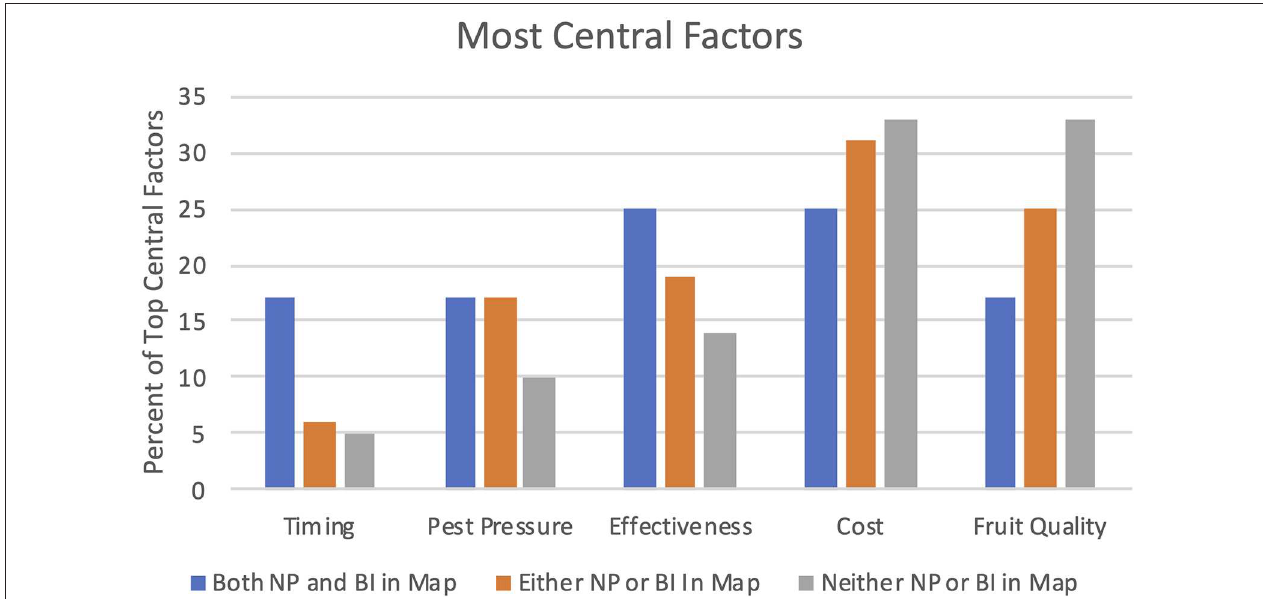
FIGURE 4 | The five highest-scoring factors according to their centrality, based on the inclusion or omission of the factors natural predators (NP) and/or beneficial insects (BI) in their maps. Percentages shown indicate the number of times a particular factor was included in the top three centrality scores for respondents divided by the total number of top three scores (therefore the highest possible score is 33%). For example, 12 respondents included both NP and BI in their maps: 9 had “effectiveness” in their top three scores; the total number of top 3 scores is 12 × 3 = 36, and 9/36 =